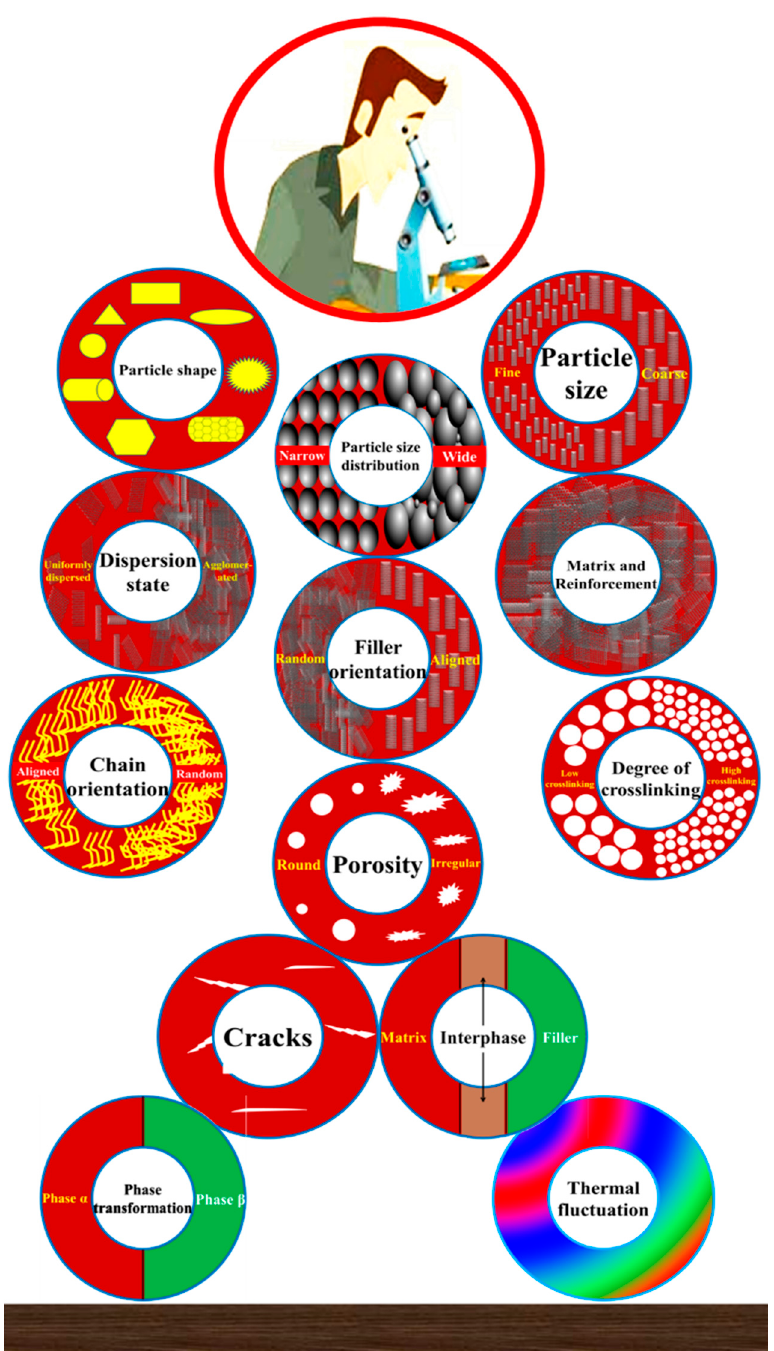
Figure 3. Various aspects of microstructure.